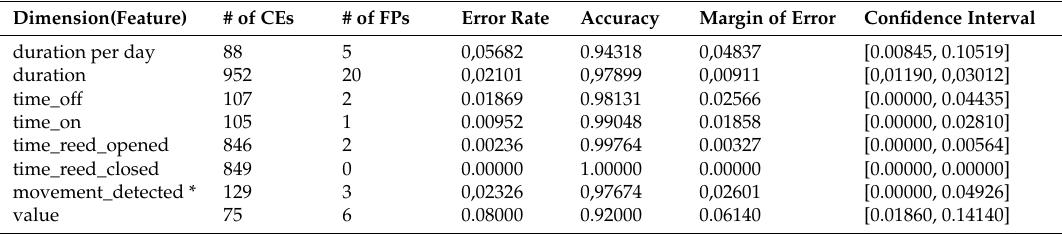
Table 3. Validation results.